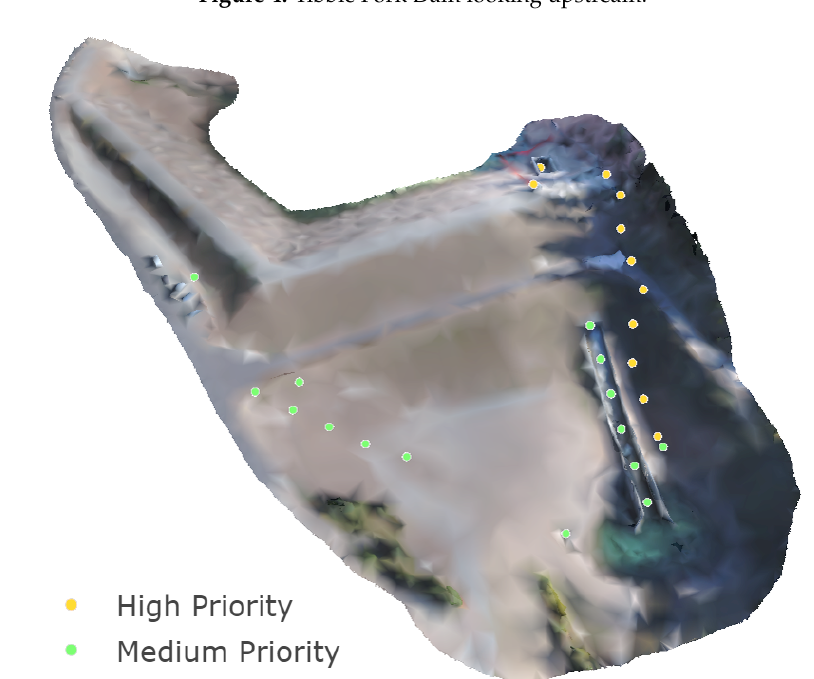
Figure 5. Coarse down-sampled model used for multi-scale modeling with priority points